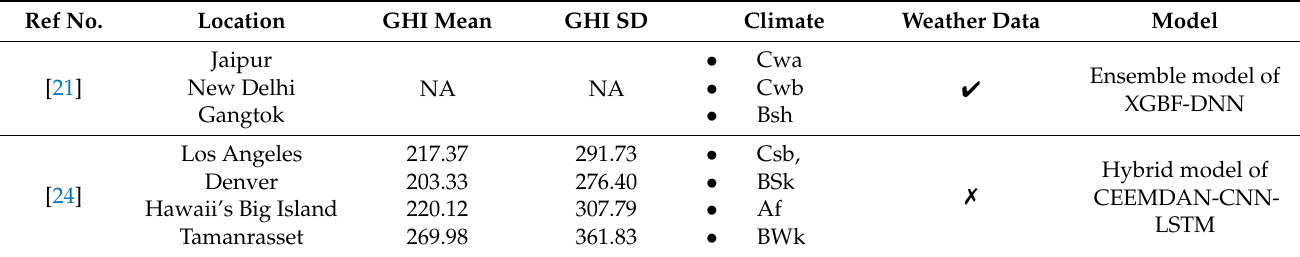
Table 12. Comparison of SENERGY to related works.